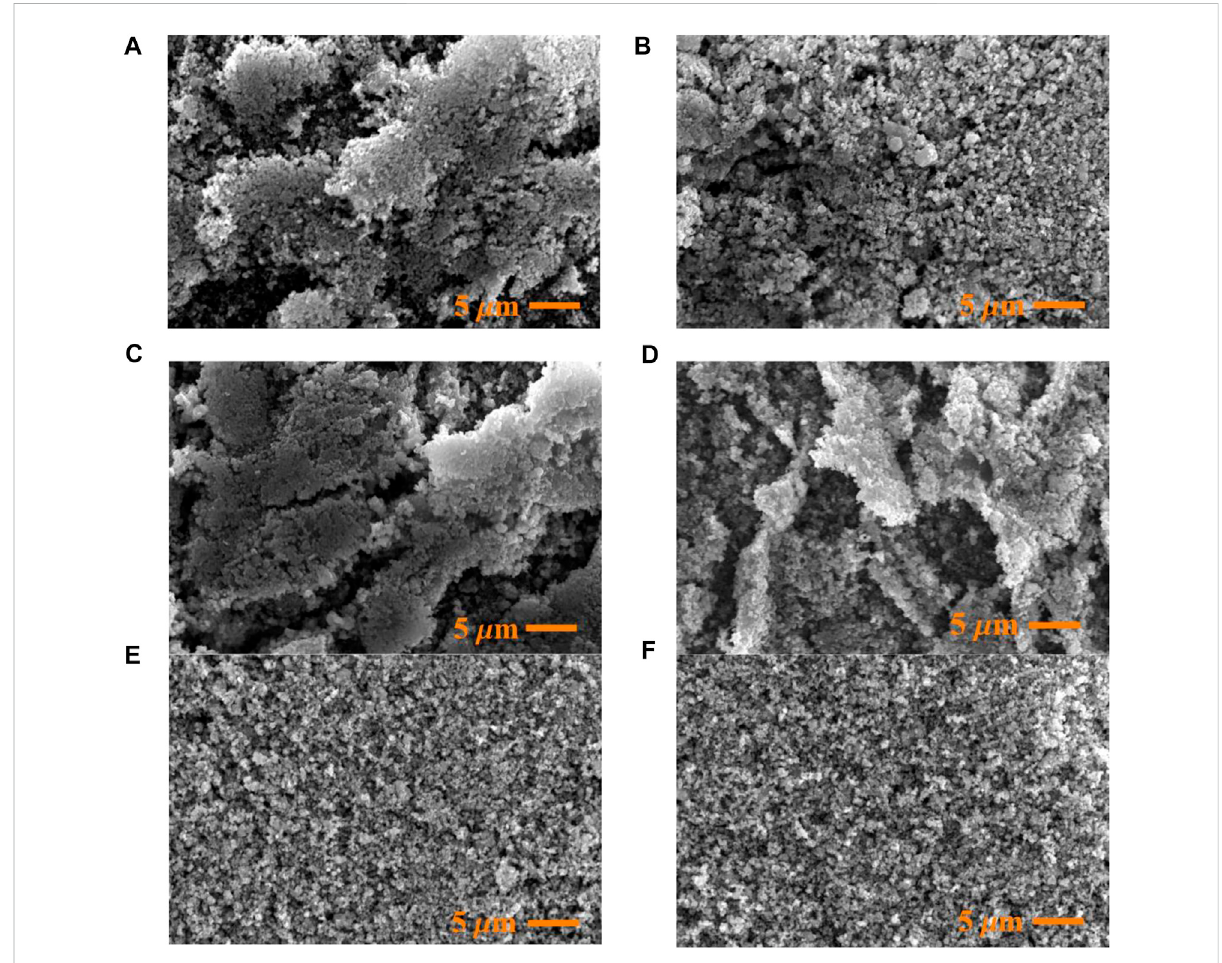
FIGURE 6 Fresh and post-reaction SEM images of catalysts employed in the hydrothermal reduction of CO 2 at different reaction times: (A) fresh catalyst; (B) 1 h; (C) 4 h; (D) 8 h; (E) 18 h; (F) 120 h.